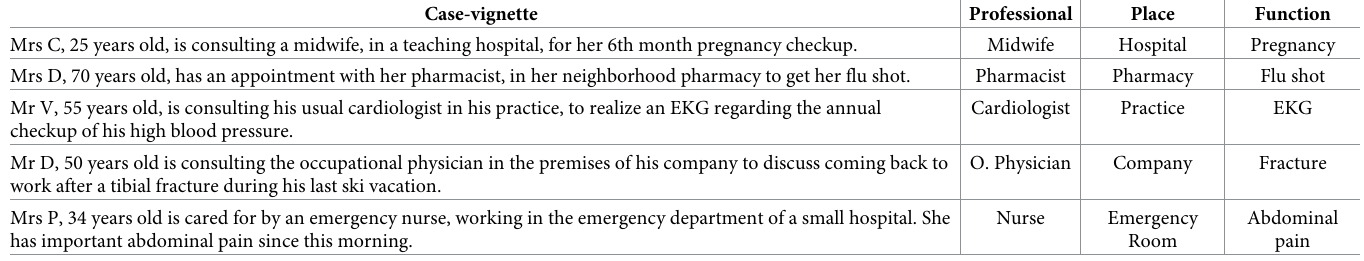
Table 3. The five